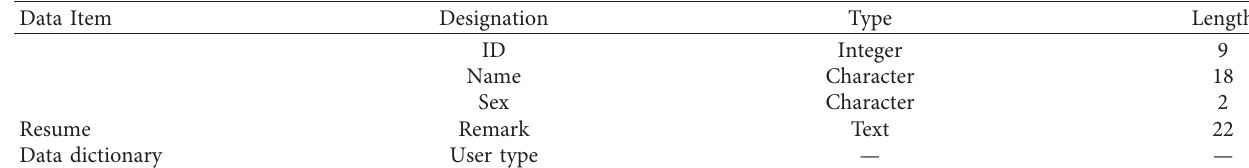
Table 1: Basic database